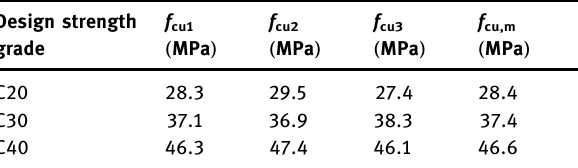
Table 4: Mechanical properties of the nano - CaCO 3 concrete Design strength